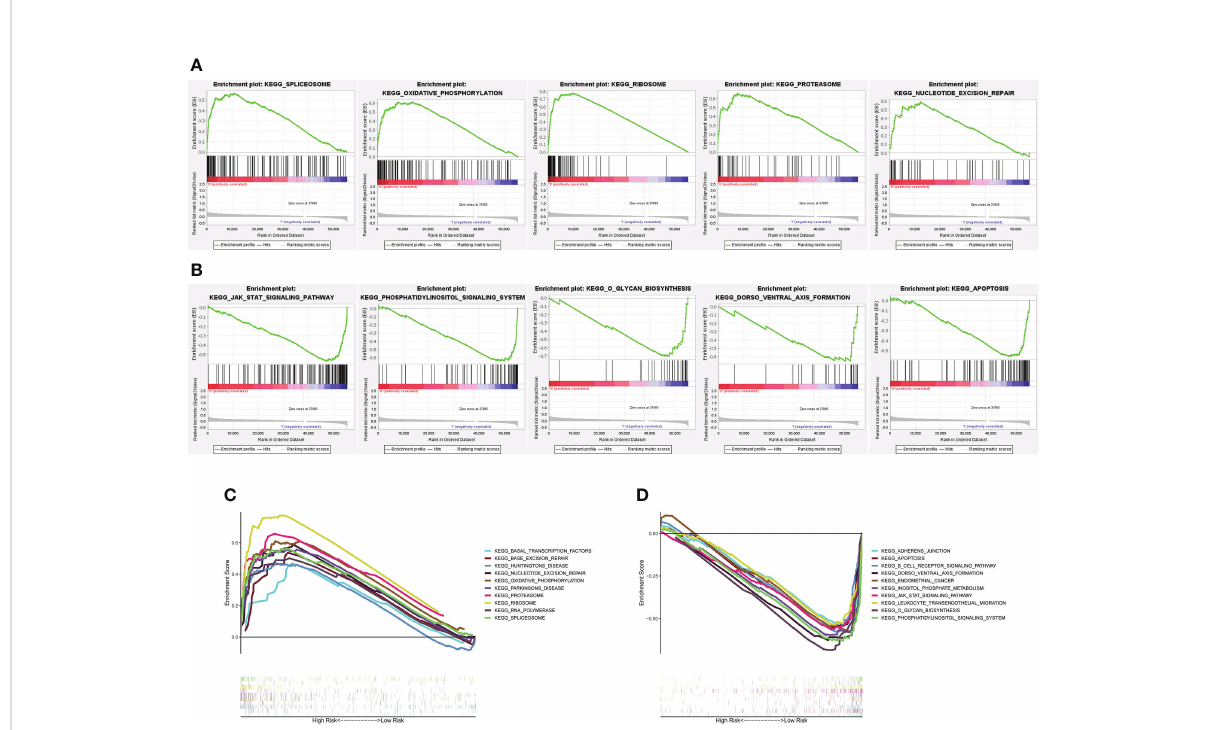
FIGURE 5 GSEA between the high- and low-risk subgroups. (A) GSEA uncovered that among the high-risk subgroup, altered genes were primarily enriched in spliceosome genes, oxidative-phosphorylation, ribosome, proteasome and nucleotide-excision-repair. (B) An analysis of GSEA revealed that altered genes in the low-risk group were primarily enriched in Jak-stat-signaling-pathway, phosphatidylinositol-signaling-system, o-glycan-biosynthesis, dorso-ventral-axis-formation, and apoptosis. (C, D) First 10 signaling pathways by KEGG analysis in the two